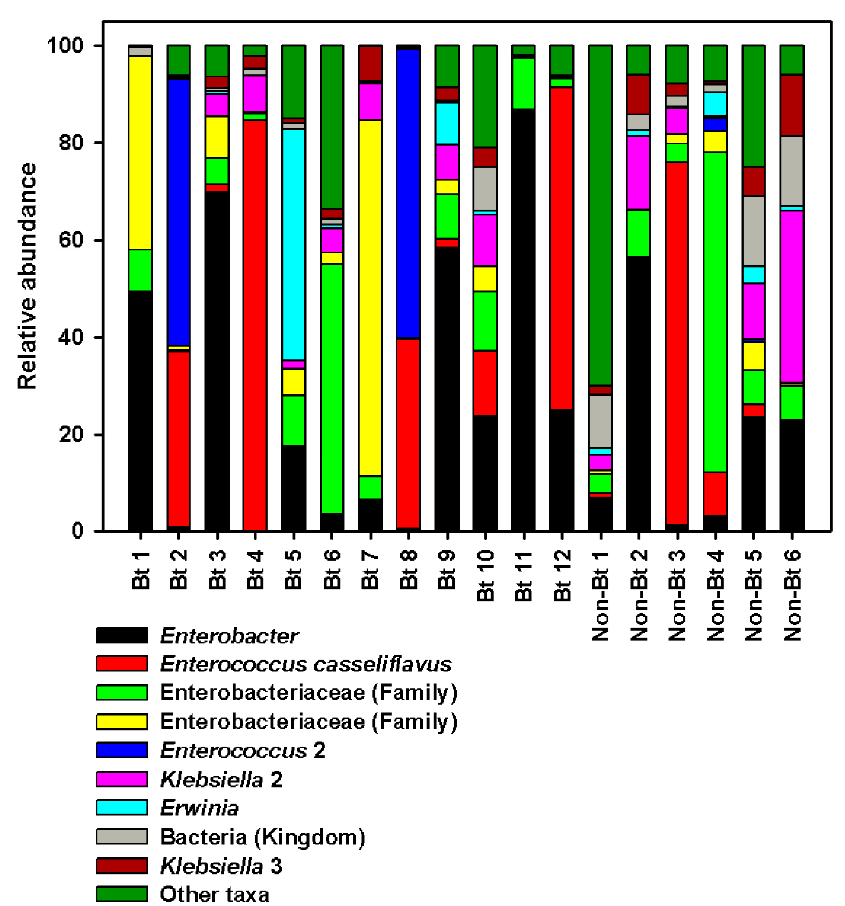
Figure 7. Relative abundance of major bacteria in DNA samples from H. zea larvae (third stadium) at the highest taxonomic resolution (level 7, species level). Bars represent proportions of each taxa. “Other taxa” refers to all the taxa with relative abundance below 3% over the total number of